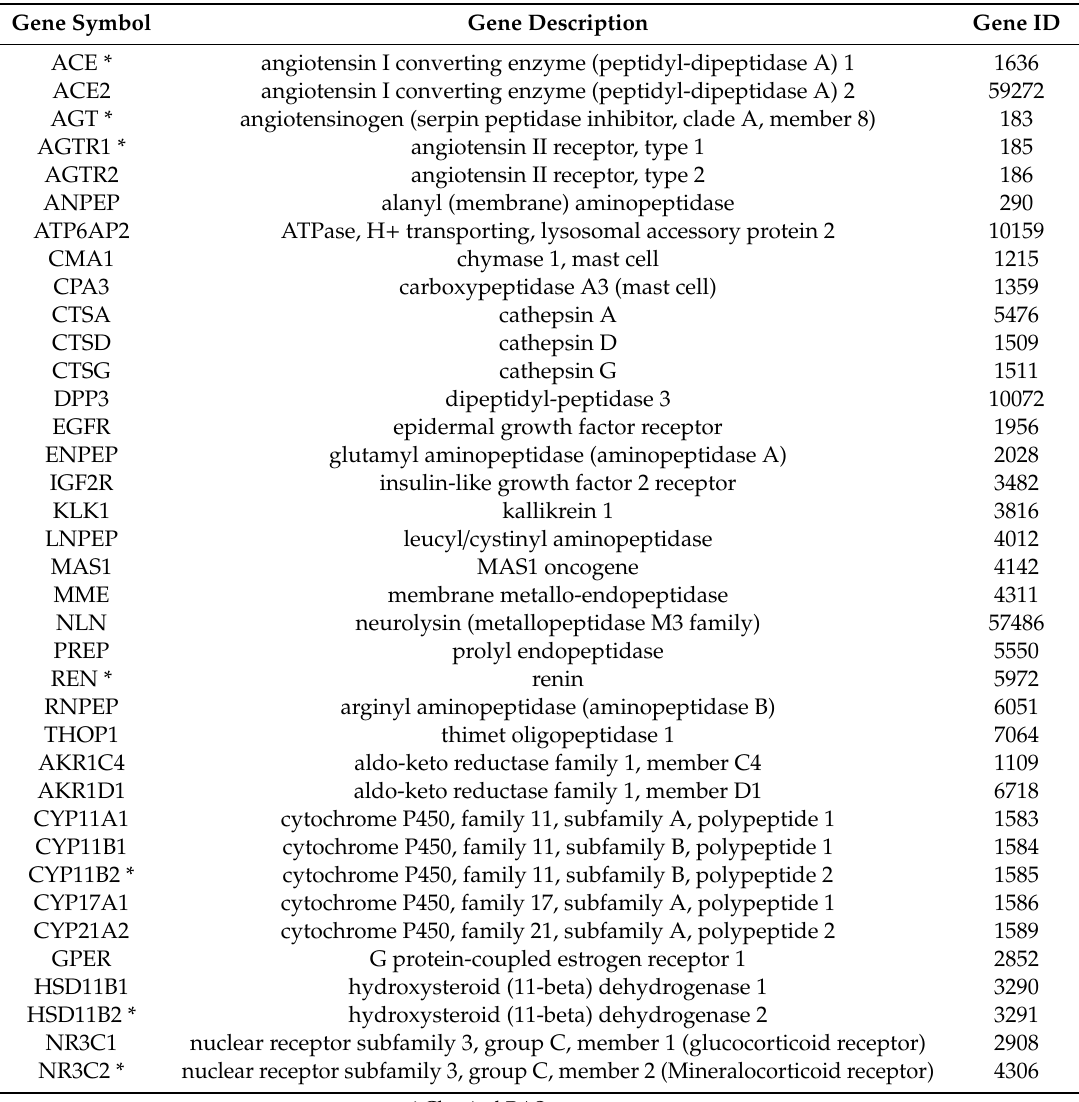
Table 1. Extended renin-angiotensin-aldosterone system